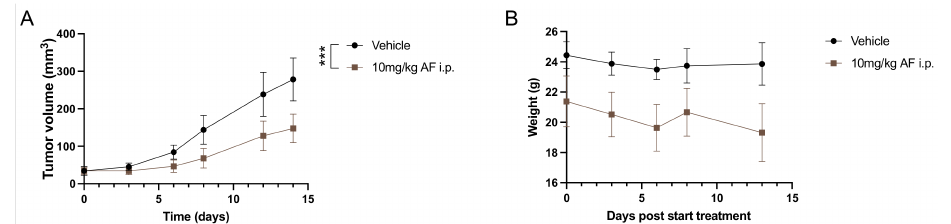
Figure 1. Effect of intraperitoneal (i.p.) injections with a high dose of auranofin (AF) on 344SQ tumor- bearing 129S2/SvPasCrl (129)-mice. ( A ) Tumor growth kinetics of 344SQ tumor-bearing 129-mice after treatment with 10 mg/kg AF via i.p. injections for 14 consecutive days. ( B ) Body weight of 129-mice after daily treatment with 10mg/kg AF via i.p. injections over a period of 14 days. Data represent mean ± SD. N = 5 mice per group. *** p ≤